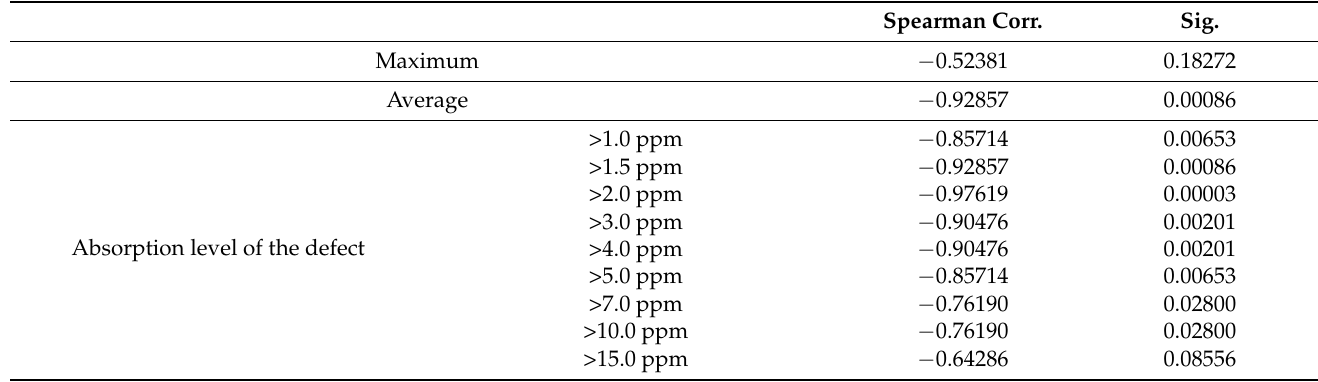
Table 4. Spearman correlations between zero probability damage thresholds and the density of the defects with different absorption levels.